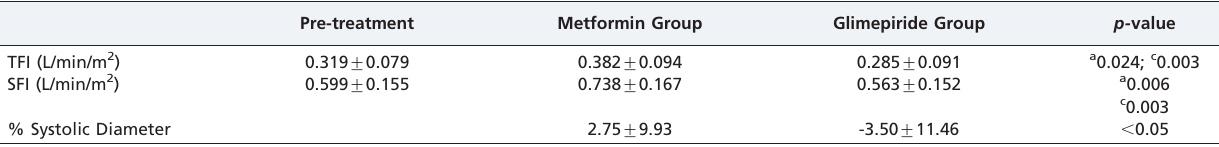
Table 3 - Total (TFI) and systolic (SFI) flow indices and percentage changes in the systolic diameter of the carotid artery.